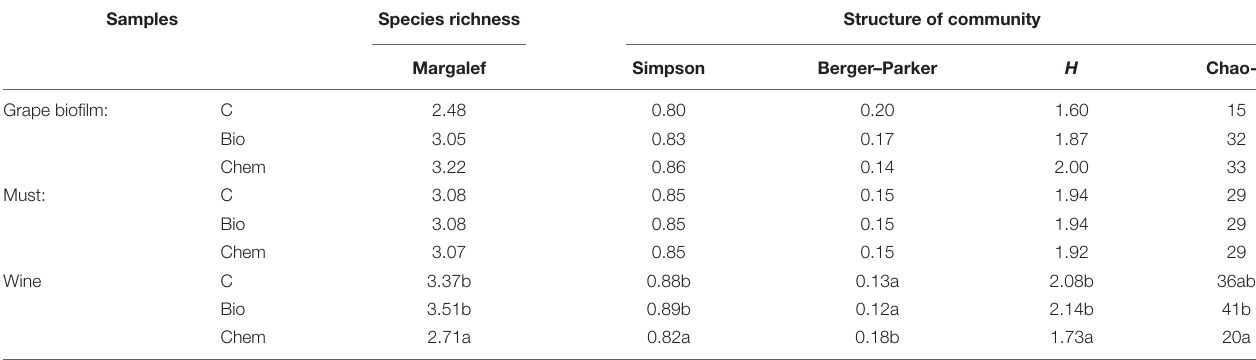
TABLE 1 | Microbial alpha diversity indexes (C: control, Bio: bio-fungicide, and Chem: chemical fungicide) assessed for the samples (grape biofilm, must, and wine), and statistical analysis at the same stage.